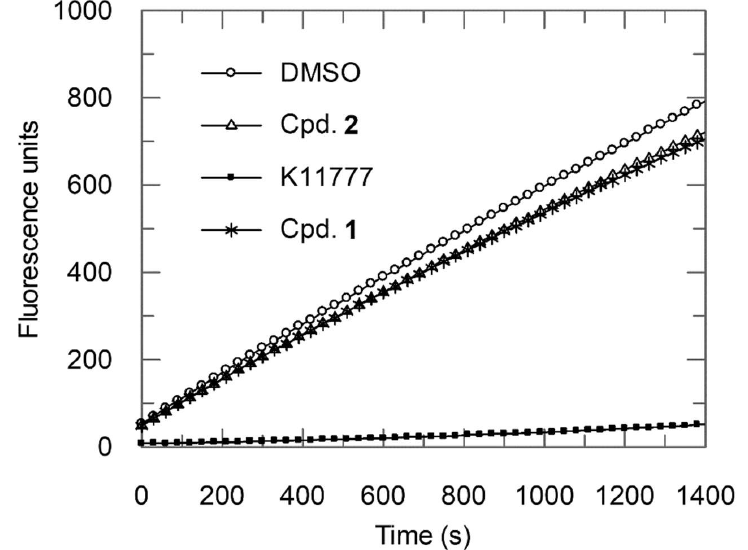
Figure 3. Dilution assays to prove reversible inhibition. Cathepsin L was incubated (15 min) with an excess of inhibitor 1 or 2 , respectively (five times the IC 50 concentration) to ensure full inhibition. Then, the mixture was diluted by 50-fold to yield a final inhibitor concentration of 10% of the IC 50 concentration. The enzyme activity, measured through addition of the substrate, nearly fully recovered in case of inhibitors 1 and 2 , whereas in case of the irreversible inhibitor K11777, a well-known vinyl sulfone [36], no recovery was observed.